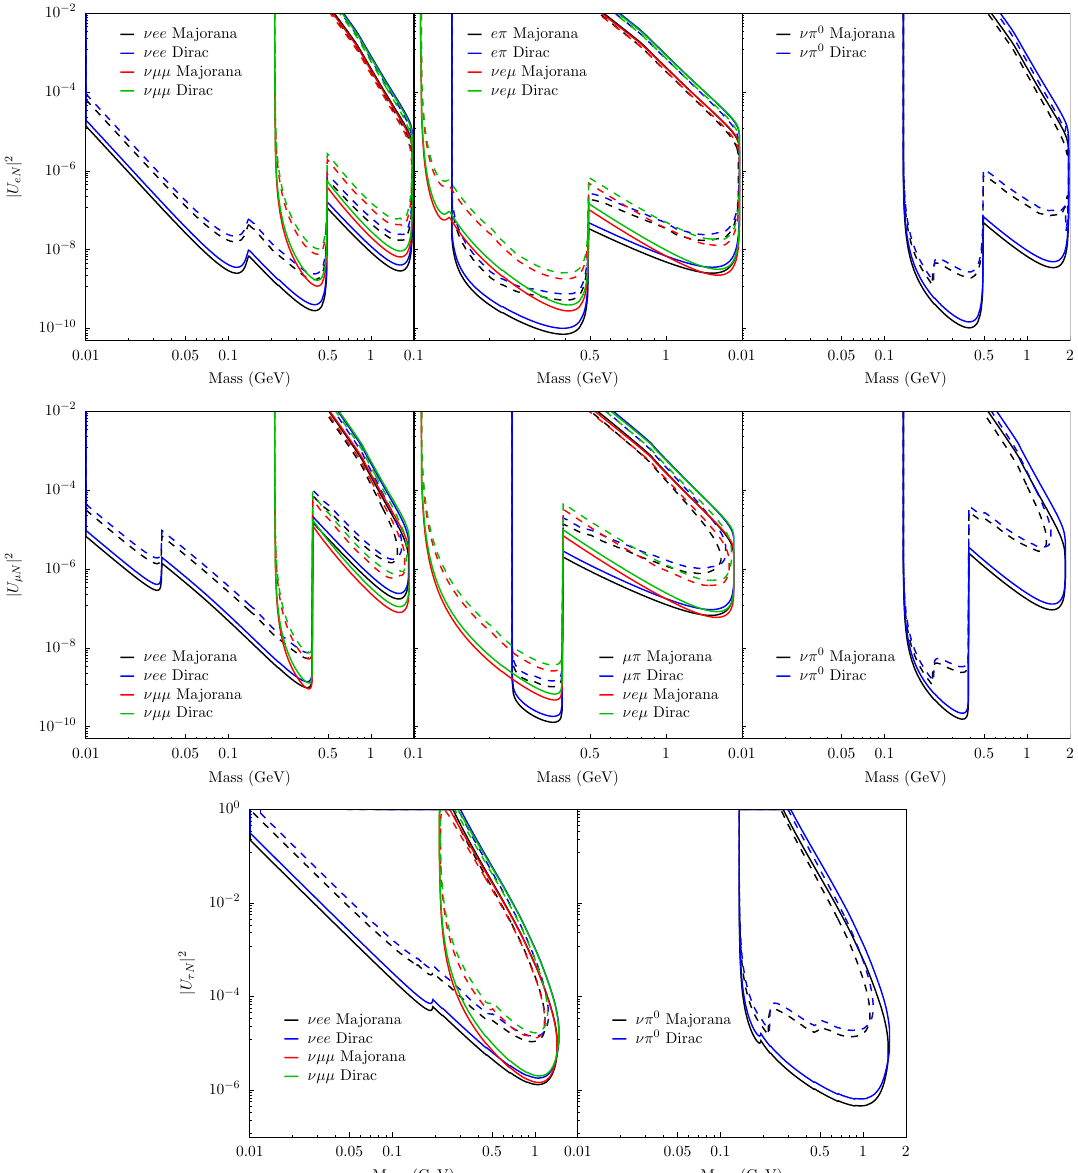
Figure 5 . The 90 % C.L. sensitivity regions to individual channels for dominant mixings j U eN j 2 (top), j U (cid:22)N j 2 (middle), and j U (cid:28)N j 2 (bottom) are shown. The solid lines correspond to the analysis before the background analysis, which is equivalent to a weighting factor W d = 1 (see eq. (5.3)). The dashed lines are drawn after our background analysis. The distinction between the fermionic natures are explained in the colour key.